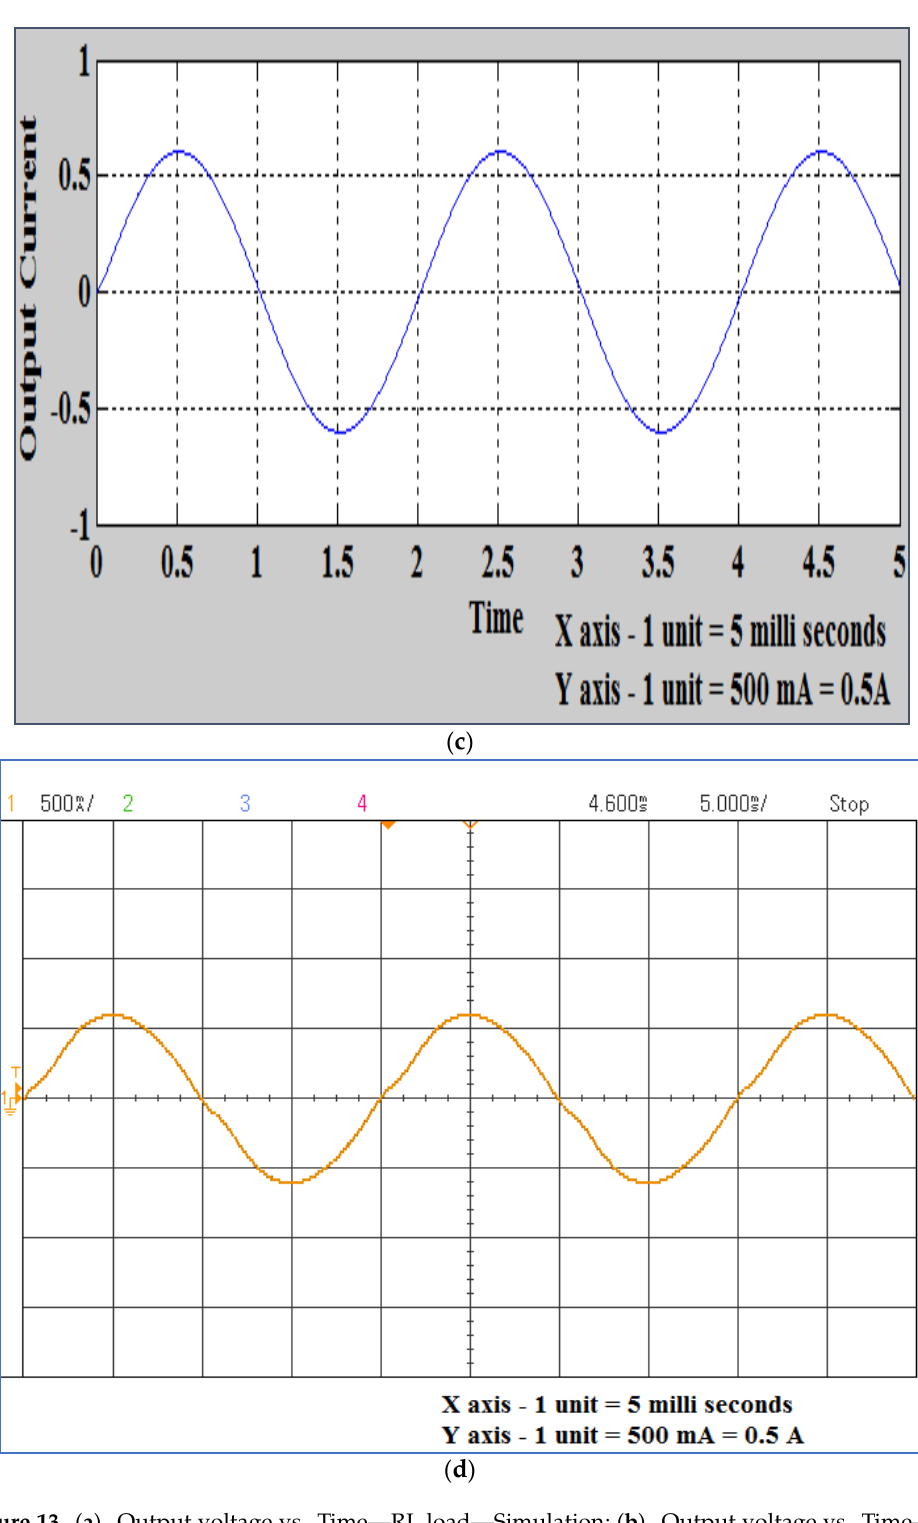
Figure 13. ( a ). Output voltage vs. Time—RL load—Simulation; ( b ). Output voltage vs. Time—RL load—Experimentation; ( c ). Output current vs. Time—RL load—Simulation; ( d ). Output current vs. Time—RL load—Experimentation.